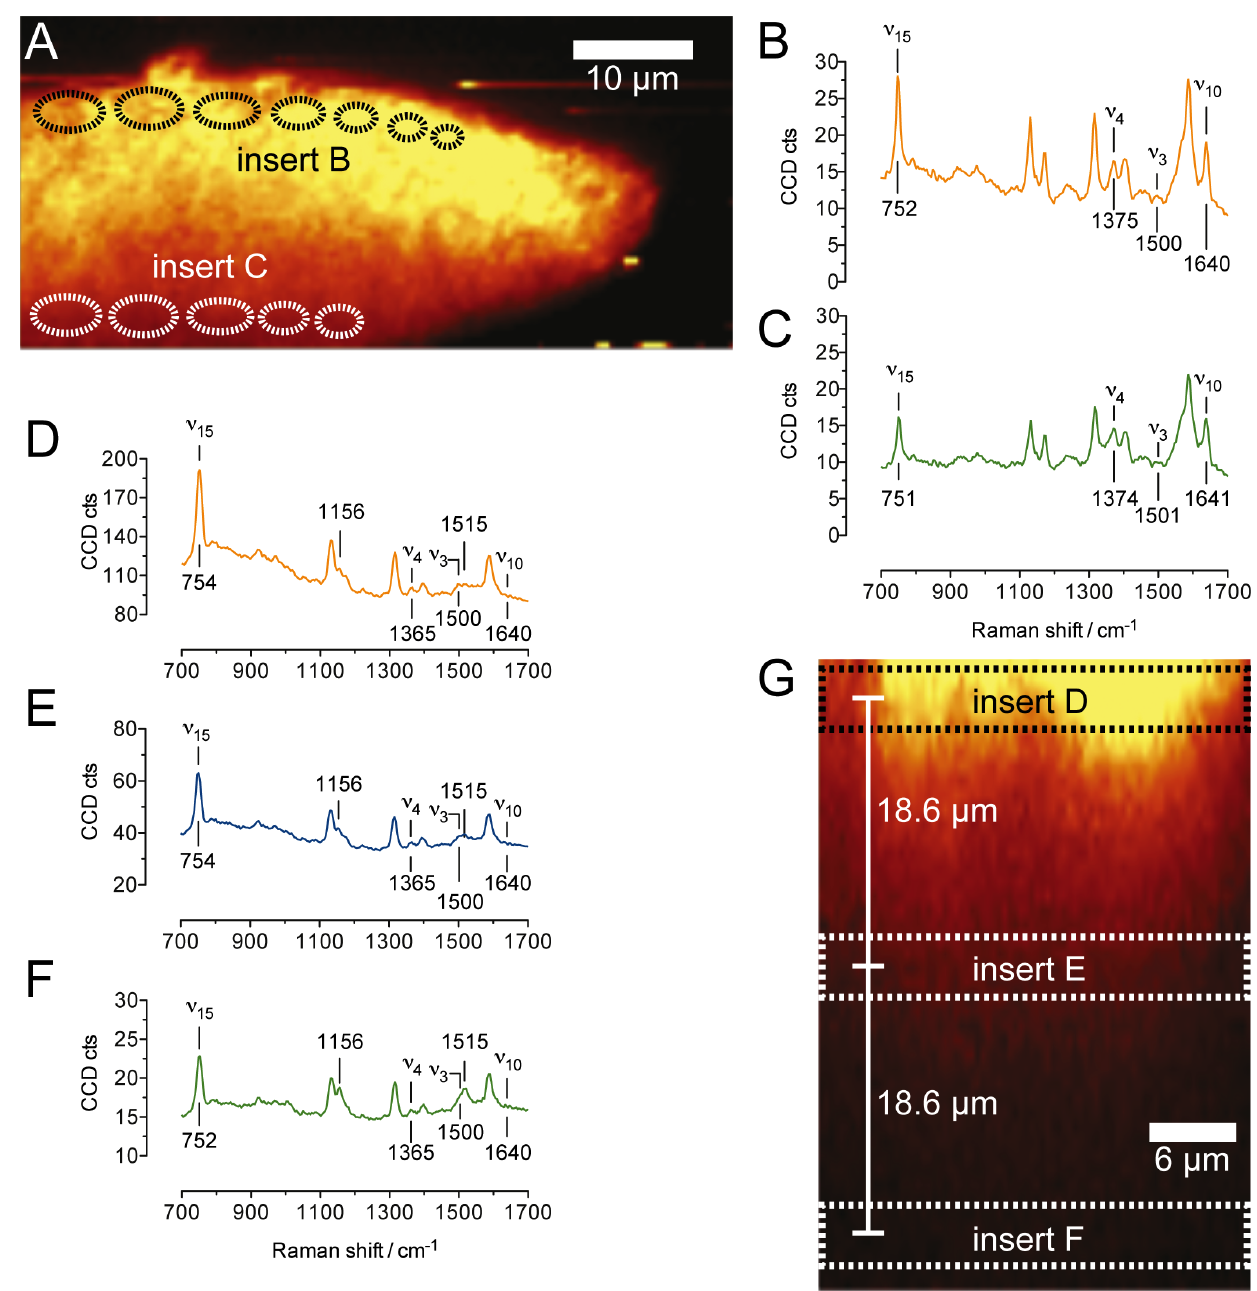
Figure 6. Raman sectional images and RR spectra averaged at different biofilm locations (as indicated by the dashed lines in the sectional maps) obtained from electroactive biofilms at different developing stages, grown at the electrode potential of 0 V vs. Ag/ AgCl in the presence of 20 mM sodium acetate. Panels A, B, and C refer to a 10 days old biofilm with thickness , 20 m m. Panels D, E, F, and G refer to an 80 days old biofilm with thickness . 100 m m. Sectional maps are generated by binning over whole spectral information between 600 and 1800 cm 2 1 . Note that only the lower section of the 80 days old biofilm is shown in panel G. The biofilm thickness was in fact too large to be measured in its entirety in one single confocal measurement. months. These biofilms were used for regular CRRM measure- ments as described below. All potentials provided in the manuscript are relative to the Ag/AgCl reference electrode (3 M KCl, 210 mV vs. the standard hydrogen electrode (SHE)) and the in the presence of 20 mM sodium acetate as metabolic electron current density values are normalized versus the geometric donor. The potential of the working electrodes was swept between (effective) surface area (2 cm 2 ), unless otherwise indicated. a lower and an upper limit (typically 2 0.7 V and 0 V) at a scan